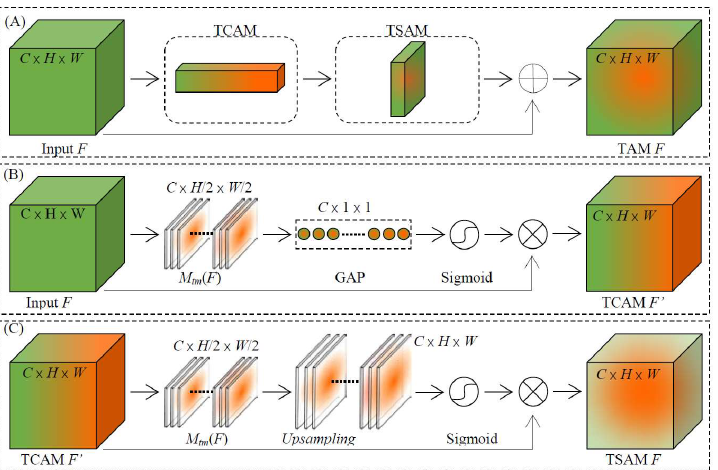
Figure 7. Structure of texture attention module: (A) TAM; (B) TCAM; (C) TSAM.